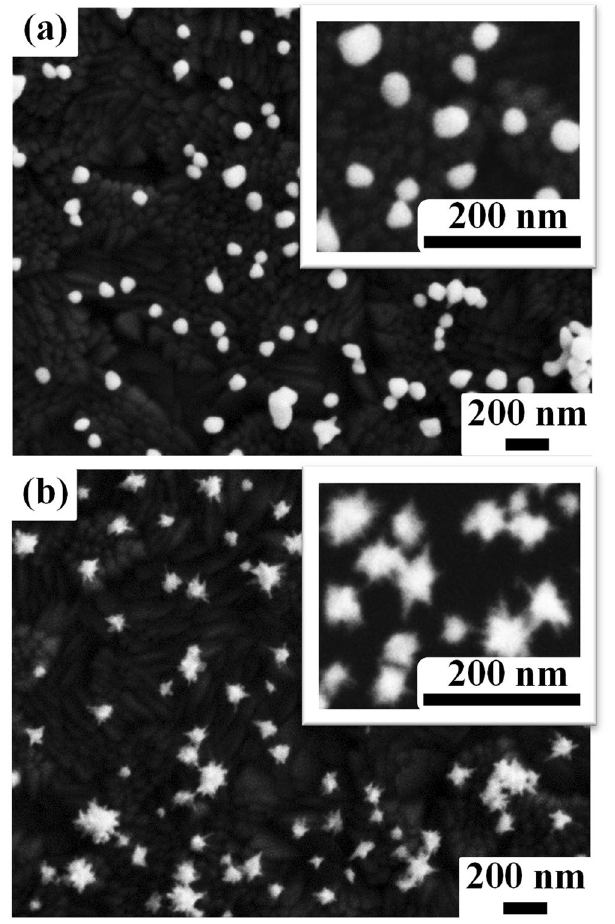
Figure 3. SEM images of the GNSs film corresponding to samples GNS1 ( a ) and GNS4 ( b ), respectively. Insets in ( a ) and ( b ) correspond to higher magnification SEM images for samples GNS1 and GNS4, respectively.